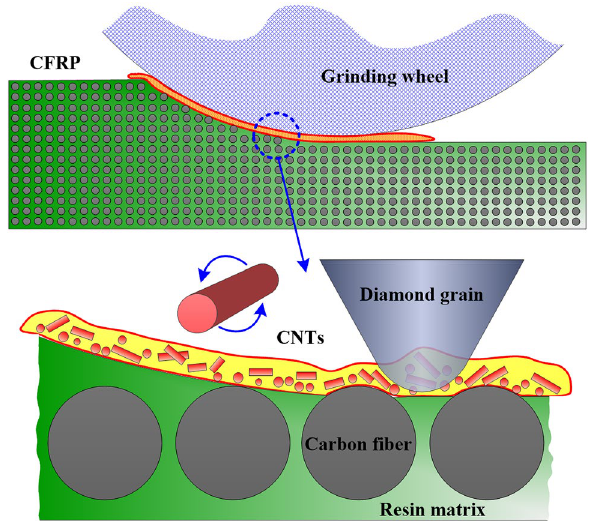
Figure 8. Grinding force and force ratio of single grain grinding under different lubrication conditions. Figures were created using the Microsoft Visio sofware (version 2010).